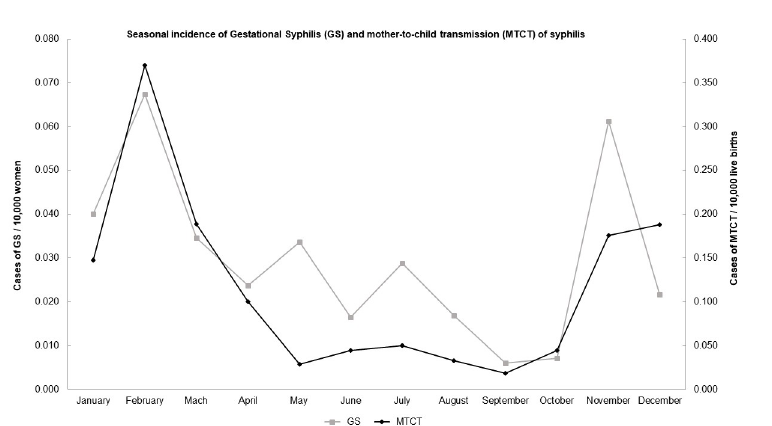
Fig 3. Dispersion graph showing the seasonal incidence of gestational syphilis (GS) from 2008 to 2013 in the Pontal do Paranapanema cities and mother-to-child transmission (MTCT) of syphilis from 2007 to 2013. Year of 2008 was excluded for GS because of the lack of monthly information. Highest number of cases were reported in February for both GS and MTCT of syphilis, followed by November for GS (late Spring and Summer). On the contrary, from March to October (Autumn and Winter) cases of GS and MTCT of syphilis did not reach half of February’s notifications. Database: 1) population: Brazilian Institute of Geography and Statistics—IBGE (2010); 2) notified cases: National System of Aggravations and Notification–SINAN